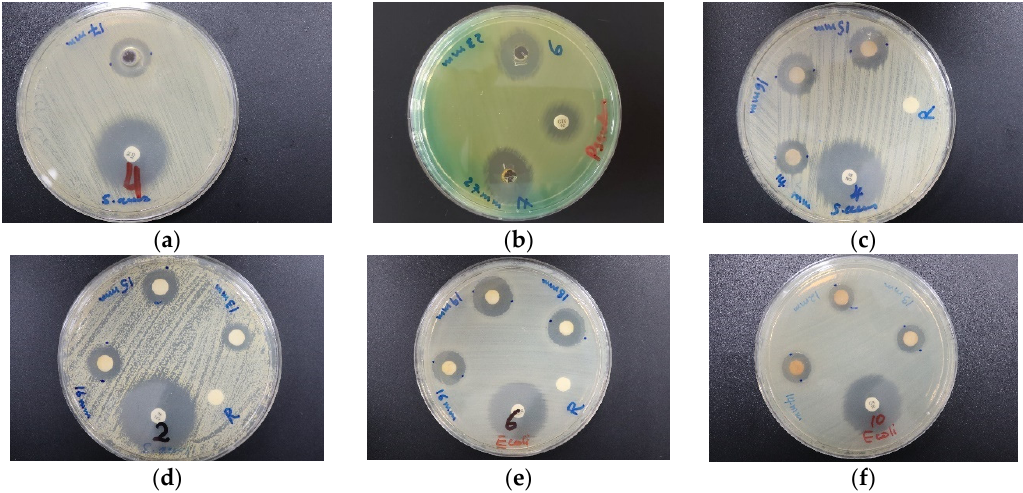
Figure 11. Antimicrobial agar plate methods on AgNP compounds with positive controls (antibiotic). From left to right: ( a ) Agar well diffusion of TCA-AgNP against S. aureus ATCC 25923 ; ( b ) TCA-AgNP-PI against P. aeruginosa WDCM 00026 . From (c–f) disc diffusion methods: ( c ) TCA-AgNP against S. aureus ATCC 25932 ; ( d ) TCA-AgNP against S. aureus ATCC 25932 ; ( e ) TCA-AgNP-PI against E. coli WDCM 00013 ; ( f ) Cinn-AgNP-PI against E. coli WDCM 00013 .